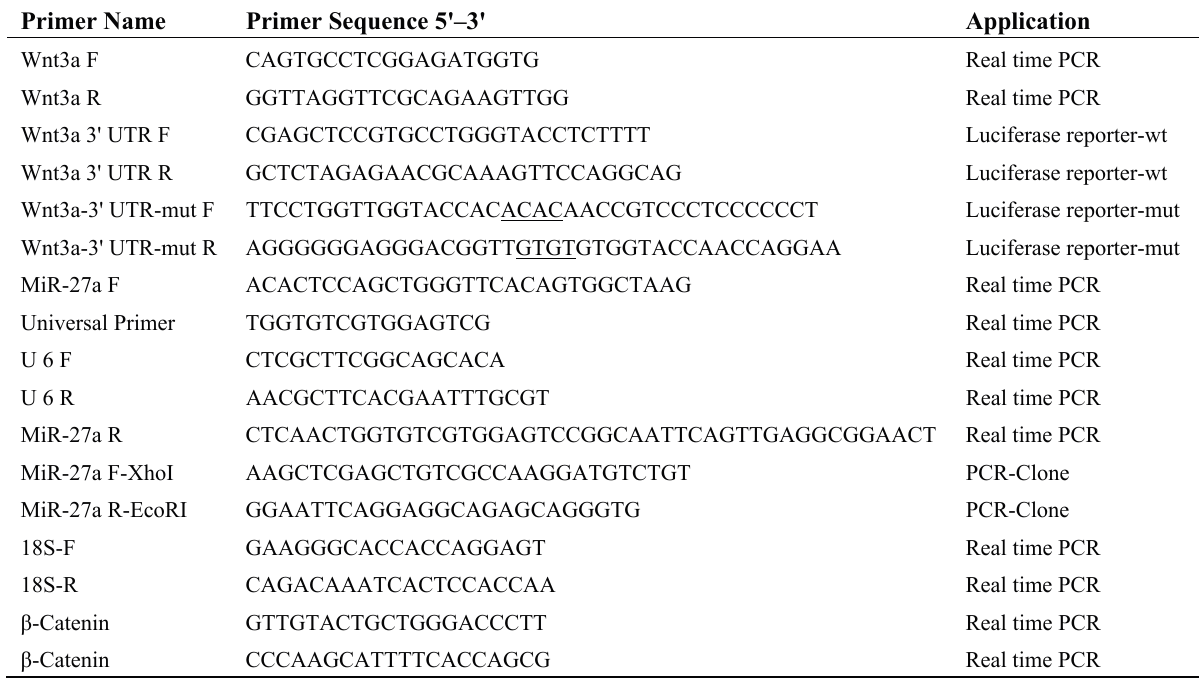
Table 1. Primers used in this